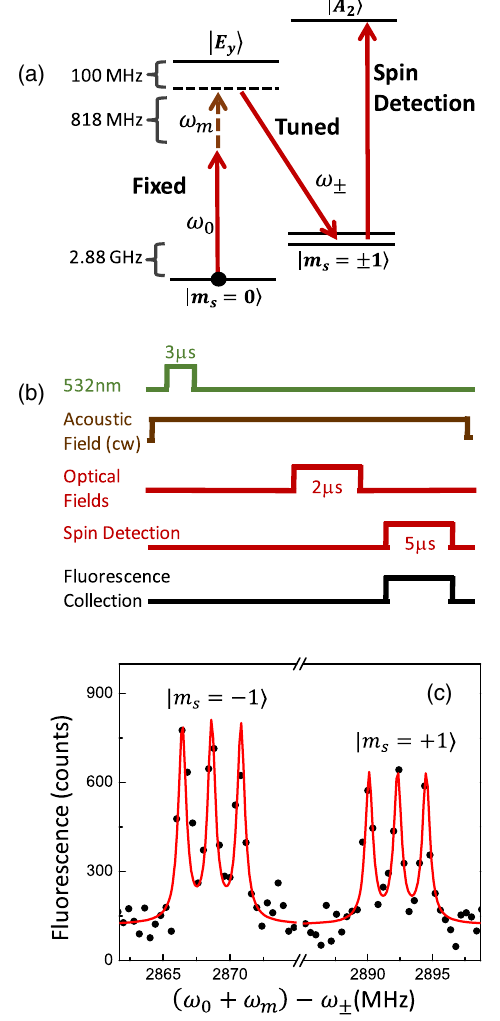
FIG. 5. (a) Energy-level diagram including spin detection used for the sideband spin transition experiments. (b) Pulse sequence used for the spectral-domain experiment. (c) Fluorescence from − ω state A 2 as a function of ω 0 þ ω (cid:2) . The solid red line is a fit m to six Lorentzians with equal linewidths. A background due to optical pumping has been subtracted from the